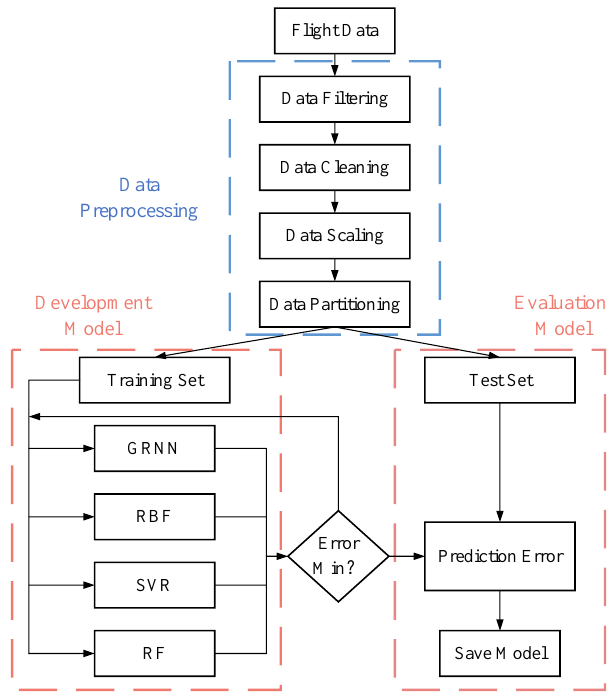
Figure 7. Process of EGT baseline modeling.